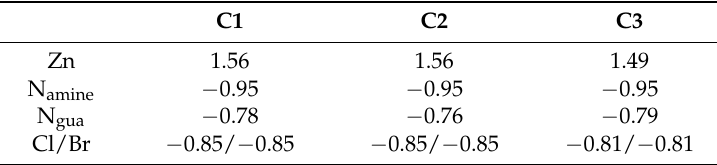
Table 3. Natural charge on zinc, N gua , N amine , and halide atoms for complexes C1 – C3 .